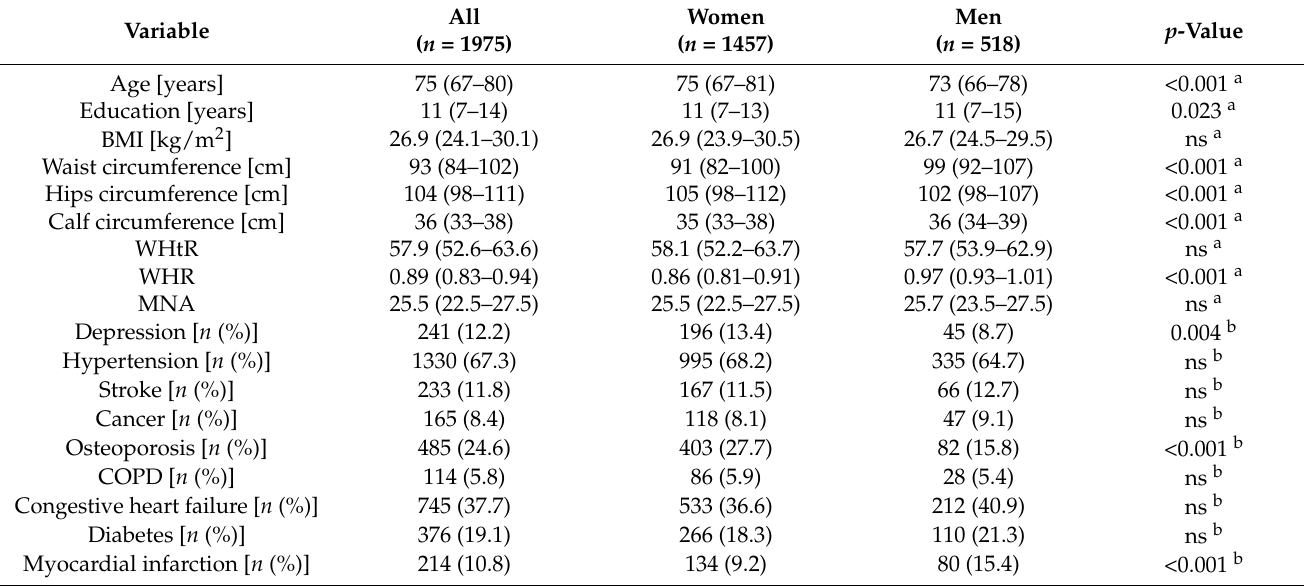
Table 1. General characteristic of the study population ( n = 1975) according to sex.